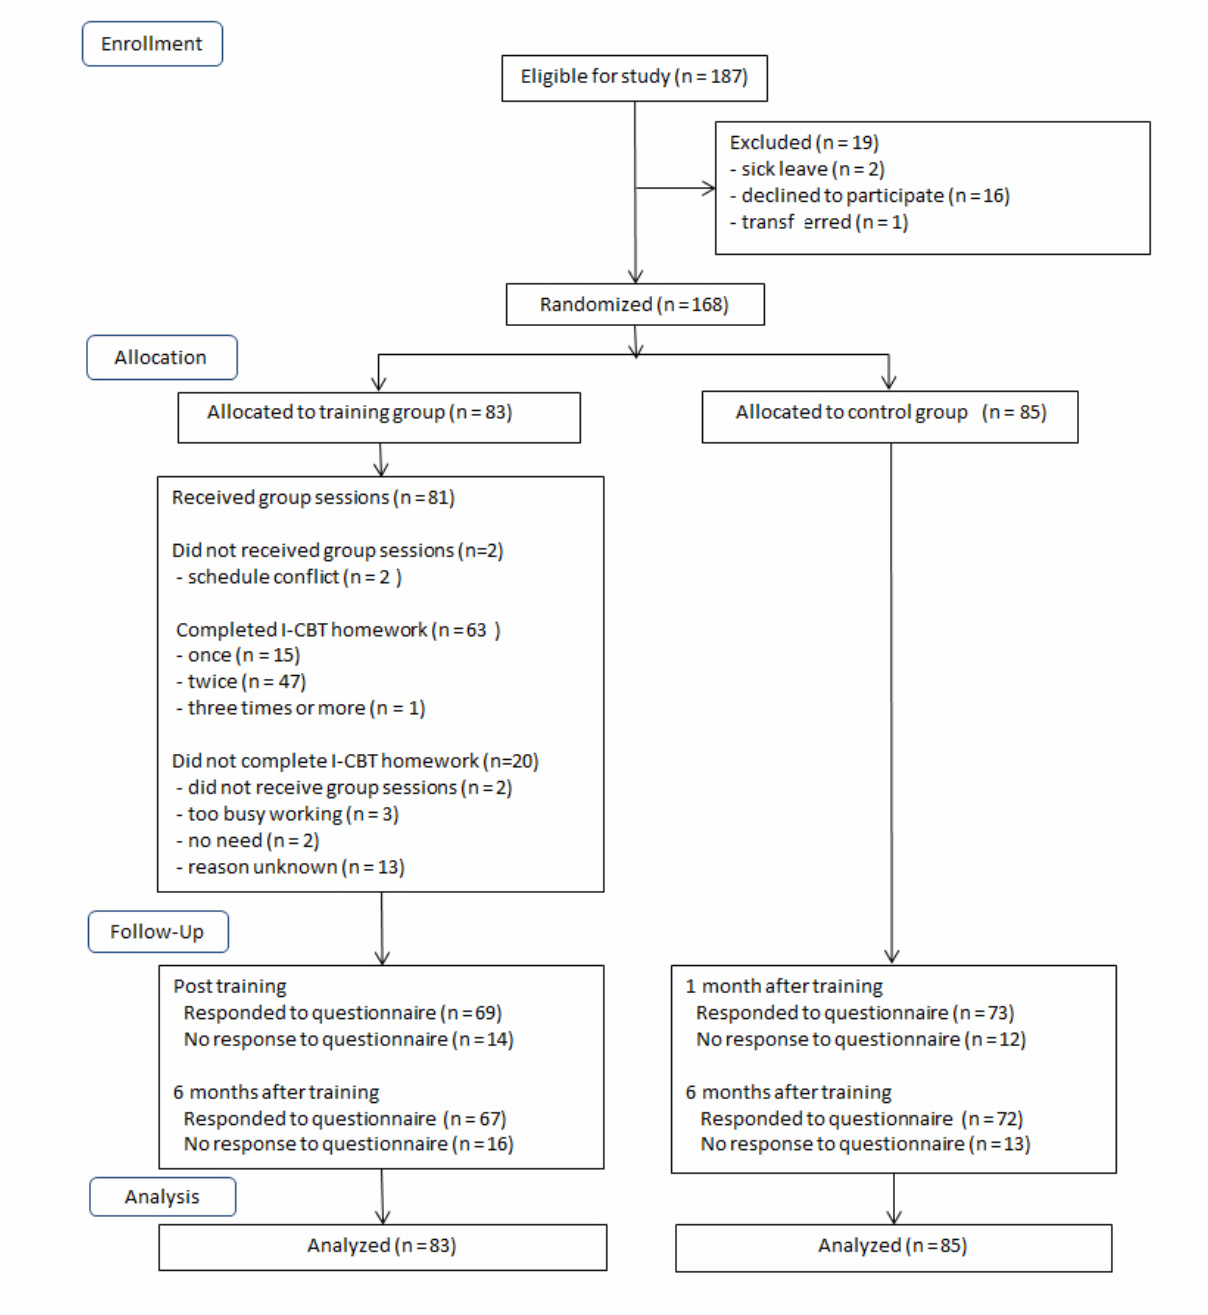
Figure 3. Trial profile.